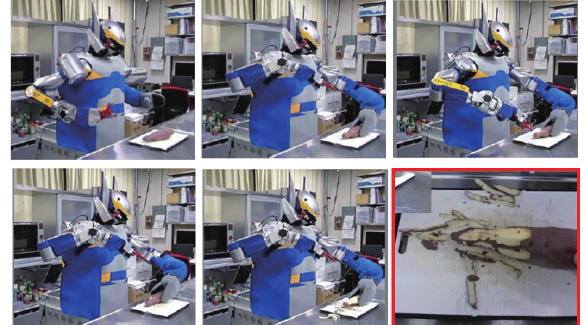
Figure 9. Peeing action and its